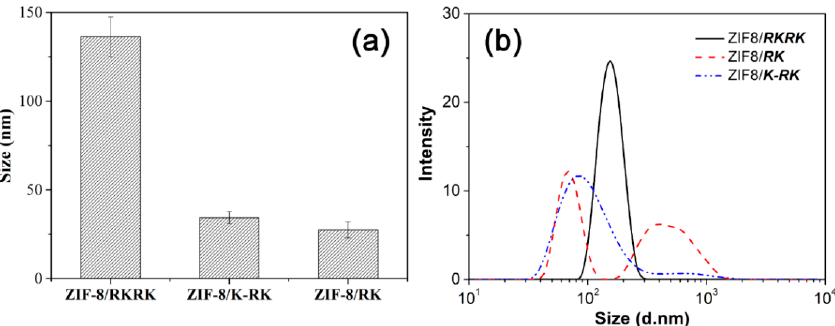
Figure 3. Size distribution of the ZIF-8 crystals prepared in the presence of RKRK , K-RK and RK , ( a ) TEM-derived sizes, ( b ) DLS size distribution.